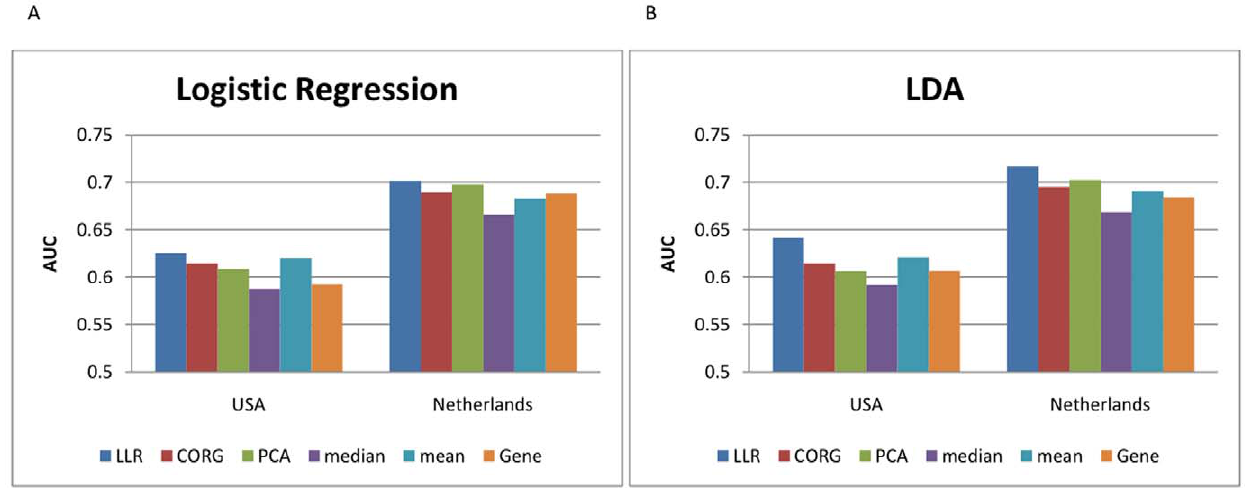
Figure 6. Performance of different classification methods. The bar charts show the average AUCs of within-dataset experiments for five pathway-based methods (LLR, CORG, PCA, mean, and median) and a gene-based method. In these experiments, the top 50 pathways have been reselected in every experiment using the designated training set. (A) Classification results based on logistic regression. (B) Classification results based on LDA (linear discriminant